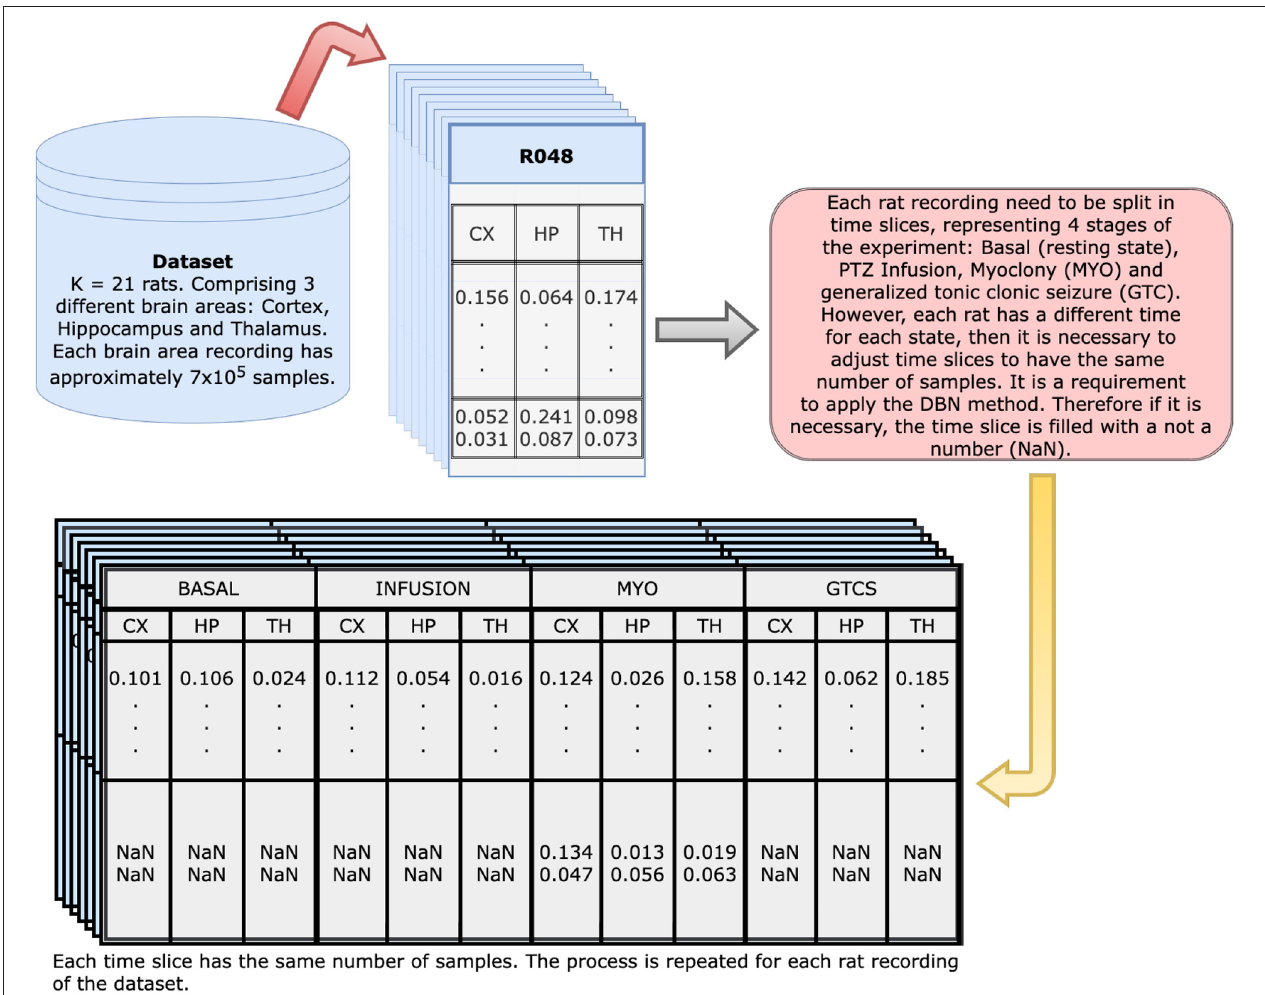
FIGURE 4 | Dynamical Bayesian Network input generation: initial dataset contain 700 thousand observations for each of the three brain regions of each animal; from such, a new dataset is generated with 12 columns representing each of the regions on all of four timestamps (Basal, Infusion, MYO and GTCS). Since all of them have different duration, the resultant table has 12 columns and as many rows as the longest time slice. The remaining columns are filled with NaN to keep the table